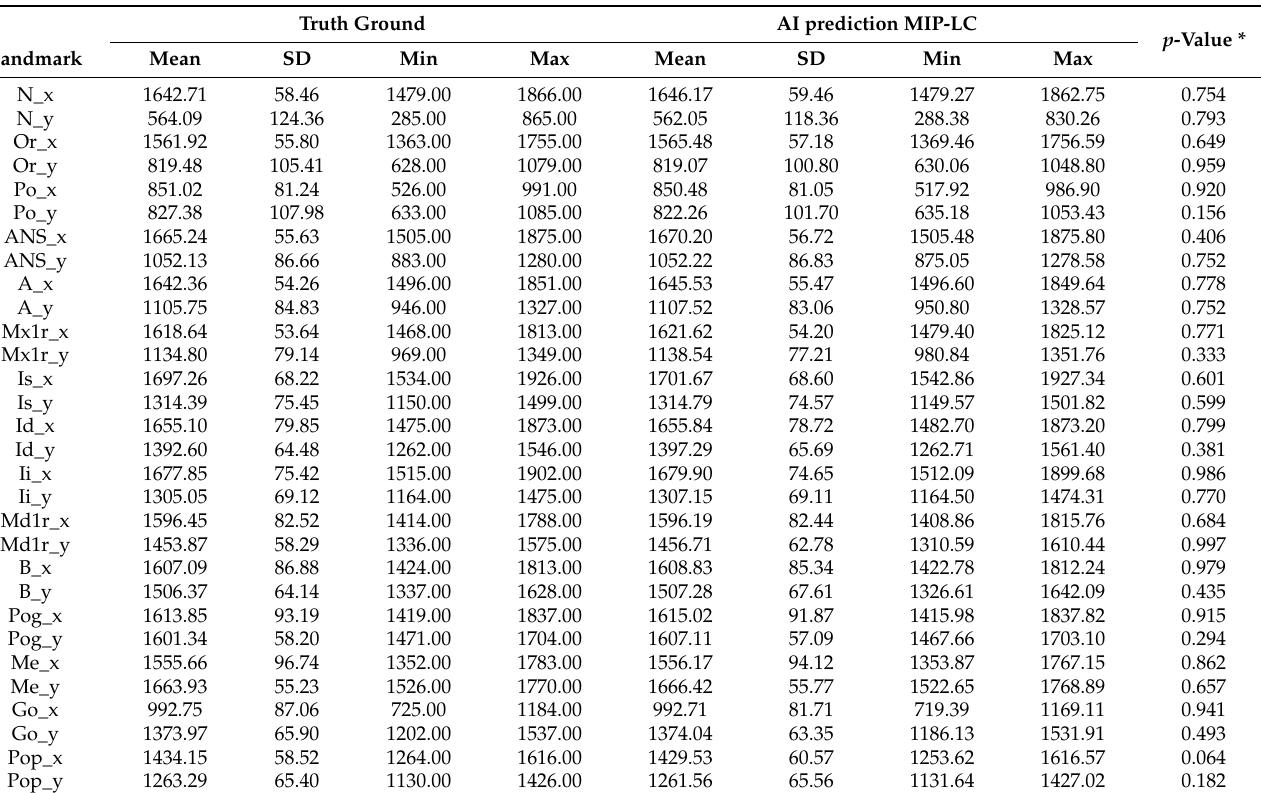
Table 4. Comparison of landmark identification between truth ground and AI prediction on CBCT synthesized MIP lateral cephalograms